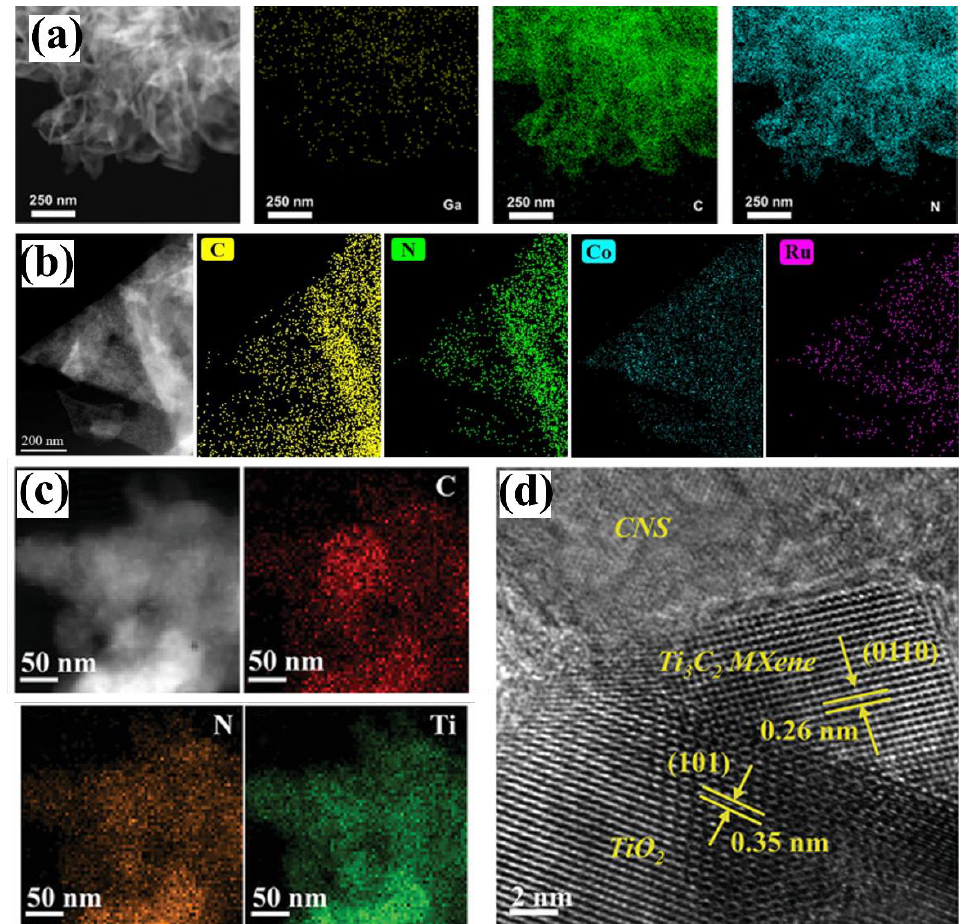
Figure 11. Elemental mapping images of ( a ) Ga-doped CN [98], ( b ) Co/Ru-doped CN [52] and ( c ) TiO 2 /Ti 3 C 2 /CN triple Z-scheme compound heterojunction. ( d ) TEM images of TiO 2 /Ti 3 C 2 /CN [21].